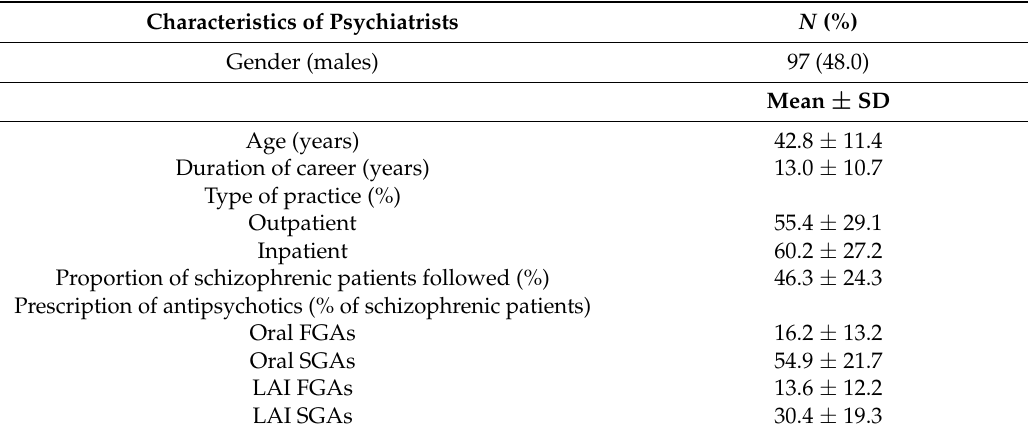
Table 1. Sample of participating psychiatrist ( N =